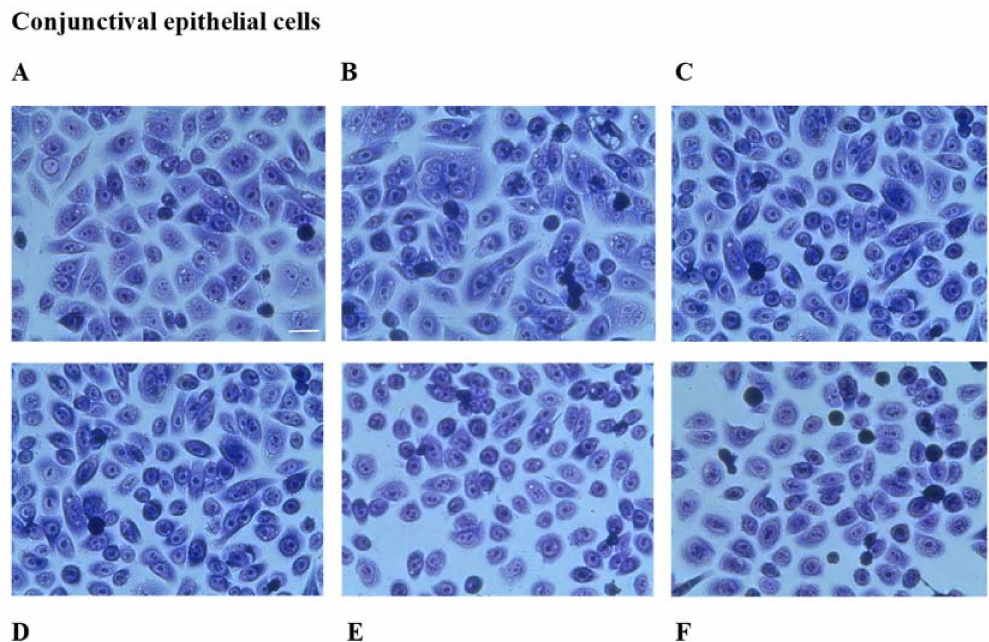
Figure 6. May–Grünwald–Giemsa (MGG) staining of the human corneal epithelial and conjunctival epithelial cells incubated with Ozodrop ® formulation for 24 h. ( A ) Control; ( B ) Ozodrop ® in a 1% concentration; ( C ) Ozodrop ® in a 2.5% concentration; ( D ) Ozodrop ® in a 5% concentration; ( E ) Ozodrop ® in a 7.5% concentration; and ( F ) Ozodrop ® in a 10% concentration. Bar = 20 µ m. Magnification 200 × .